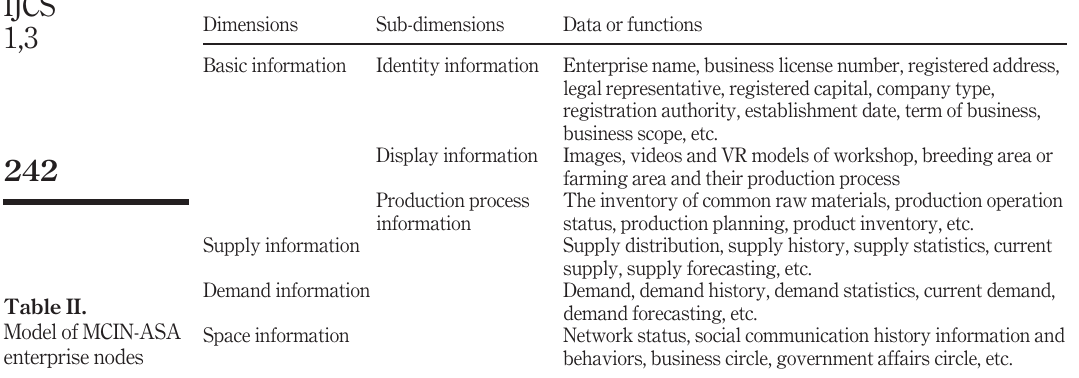
Table II. Model of